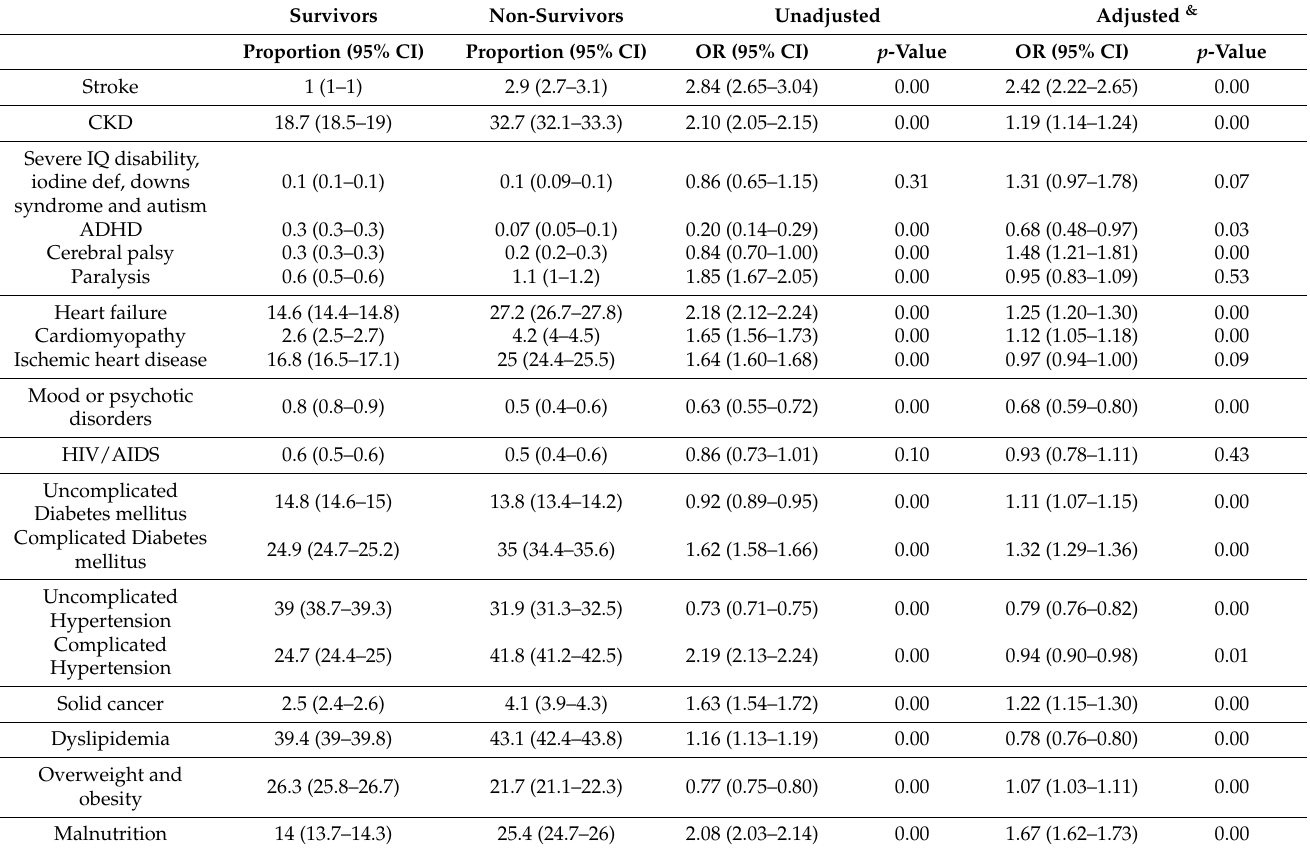
Table 7. Logistic Regression for Comorbid Medical Predictors of